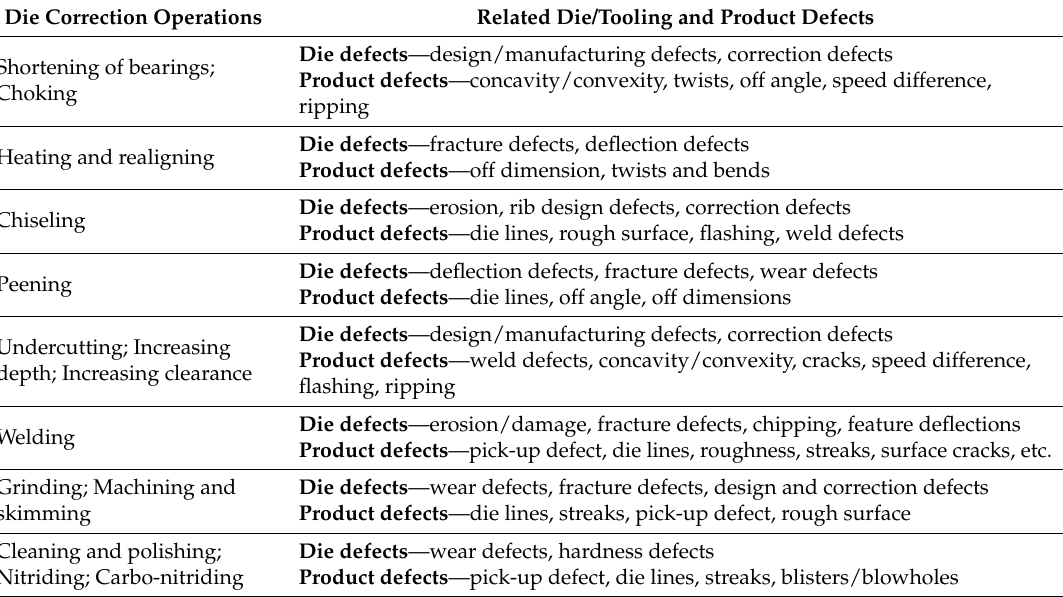
Table 3. Major die correction operations and related die and product